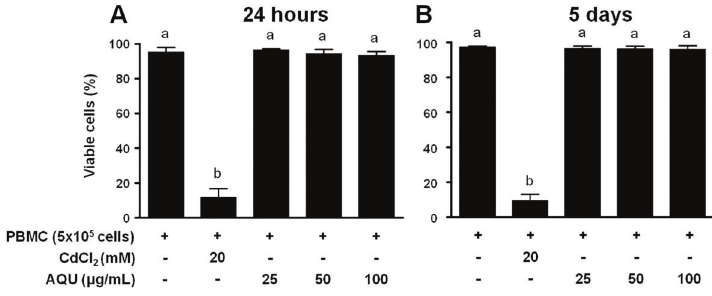
Figure 2. Apoptotic or necrotic effect of P. brasiliensis extracts. Percentage of viable, apoptotic, or necrotic cells in cultures of peripheral blood mononuclear cells (PBMCs) treated with or without P. brasiliensis extracts after 4-h incubation. Evaluation was done by fl ow cytometry (n=8). Culture treated with dimethyl sulf- oxide (DMSO) constituted the solvent control. ACE: P. brasiliensis ethyl acetate extract; AQU: P. brasiliensis aqueous extract; ETA: P. brasiliensis ethanolic